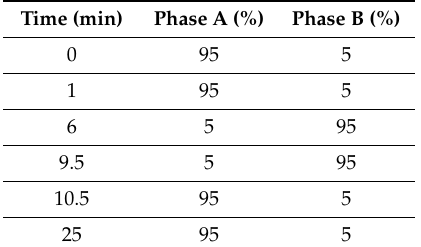
Table 1. Chromatographic gradient used for analysis by